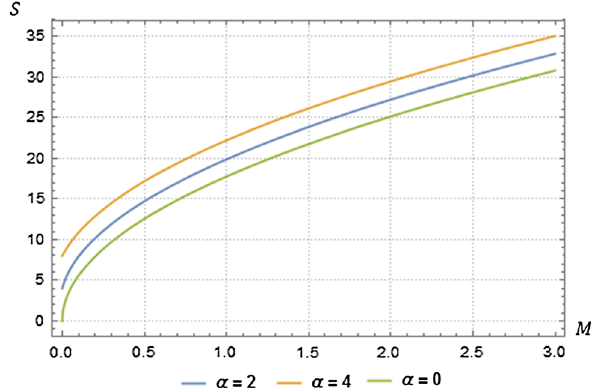
Fig. 2 A plot of the BTZ entropy and its mass for a fixed l = 0 . 5 in Planck units. Quantum corrections are mainly relevant for small mass